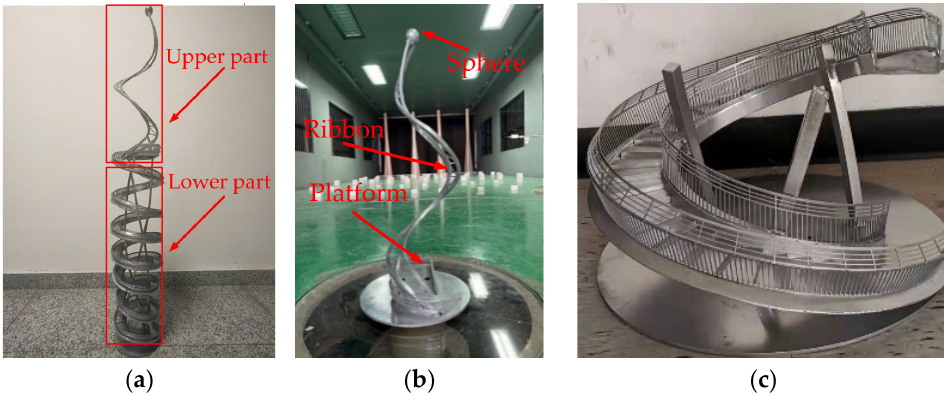
Figure 1. Wind tunnel test model of the LT: ( a ) Aeroelastic model, ( b ) Rigidity model of up part tower, ( c ) Rigidity model of the staircase.